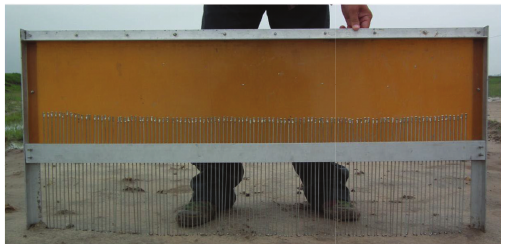
Figure 2: Measurement of surface